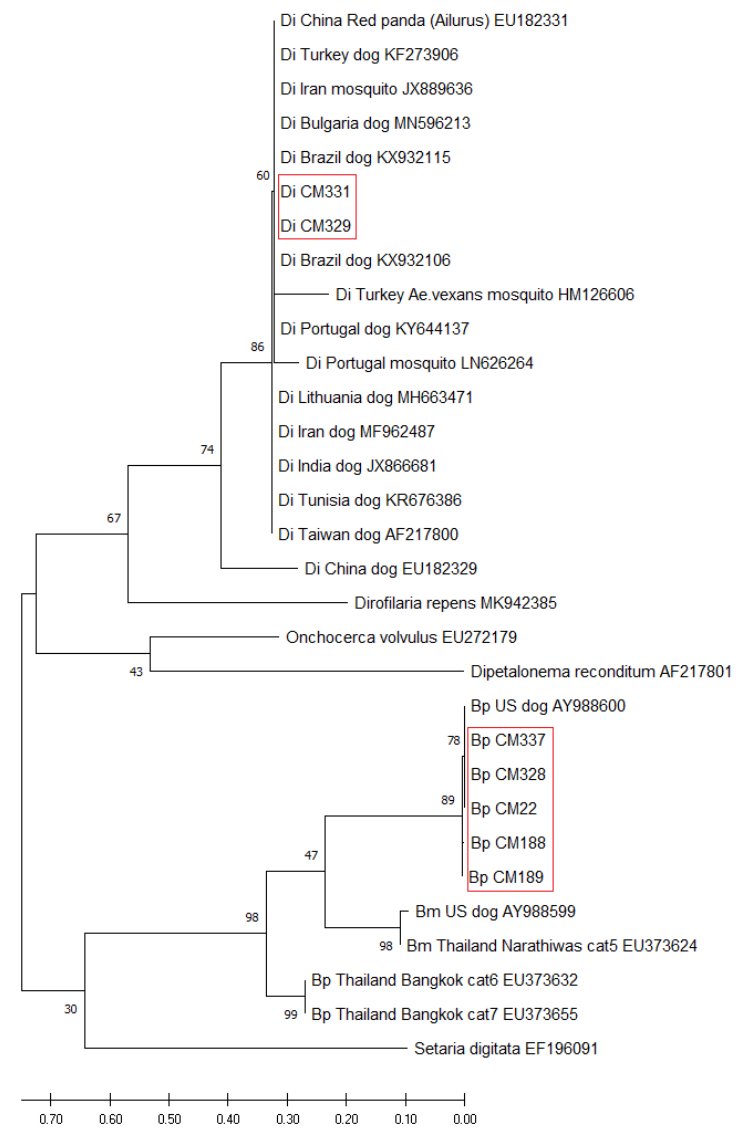
Figure 3. Evolutionary analysis of D. immitis and B. pahangi 5.8S-ITS2 region. A phylogenetic tree based on the 5.8S-ITS2 region of D. immitis (Di) and B. pahangi (Bp) from Thailand and other countries was inferred using the maximum likelihood method and the Tamura–Nei model. The tree with the highest log likelihood ( − 2536.04) is shown. The percentage of trees in which the associated taxa clustered together is shown next to the branches. There was a total of 344 positions in the final dataset . Sequences in the red outline boxes originated from the present study .